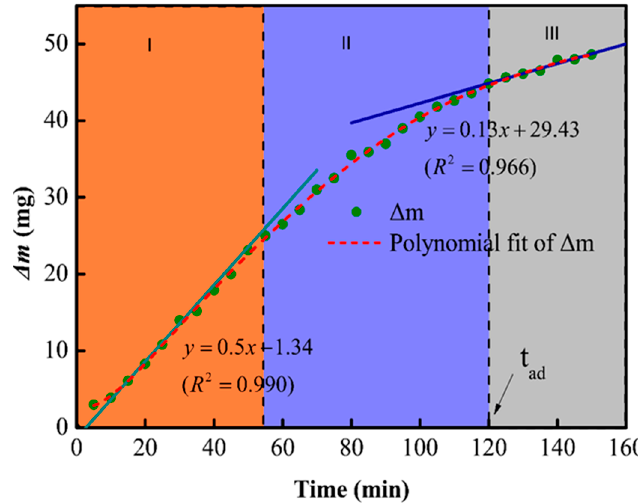
Figure 3. The relationship between change in the mass (delta-m) and time of MAS samples.